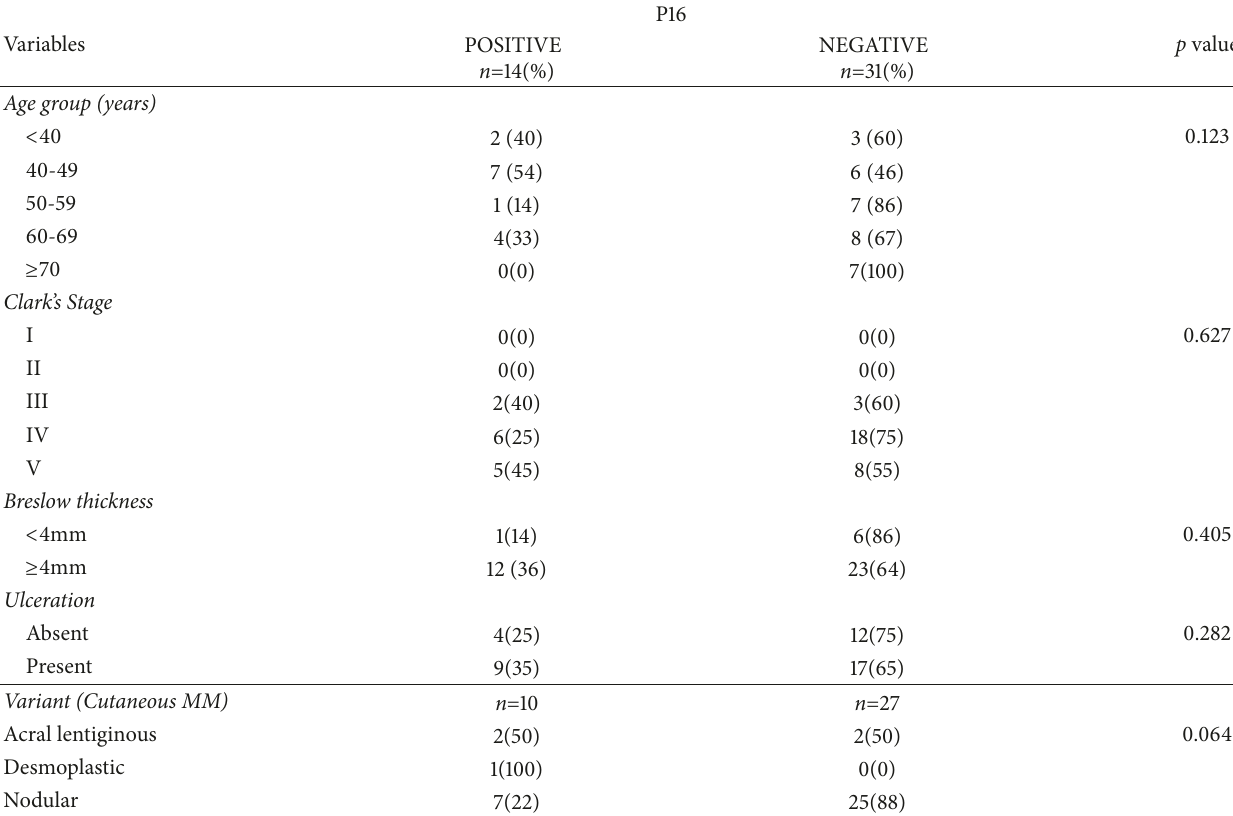
Table 1: Correlation between P16 expression and prognostic